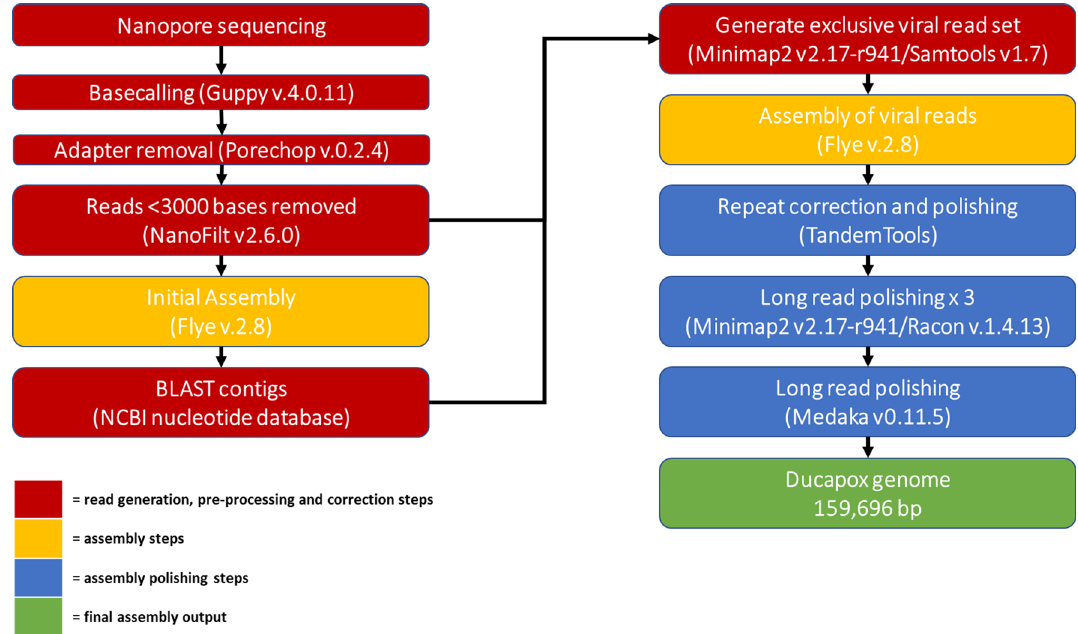
Figure 7. Bioinformatics pipeline used for the long-read only assembly of the Ducapox genome. Basecalling of reads was performed using Guppy v4.0.11. Adapter sequences in reads were removed using Porechop v.0.2.4. Reads were subsequently filtered to a minimum length of 3000 bases using Nanofilt v2.6.0. An initial assembly was performed using Flye v.2.8 (using reads containing both viral and non-viral DNA sequences), after which a BLAST search for each contig generated was performed against the NCBI nucleotide database. A file containing all non-viral reads was used to generate an exclusive viral read set by mapping reads to the non-viral contigs using Minimap2 v 2.17-r941, followed by extraction of the unmapped reads using Samtools v1.7. A Flye assembly was performed on the exclusive viral reads set, which was subsequently polished with